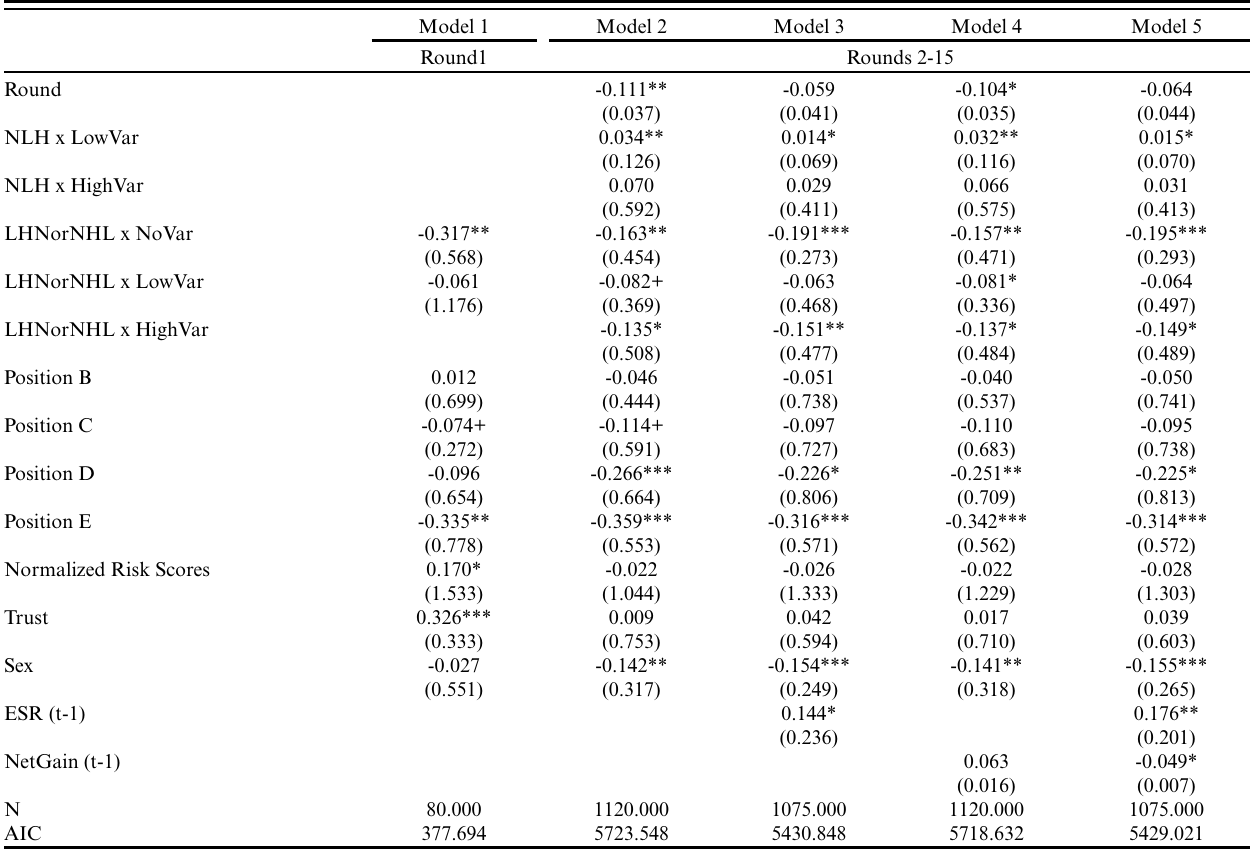
Table 4 . Results for the individual-level hierarchical model with standardized